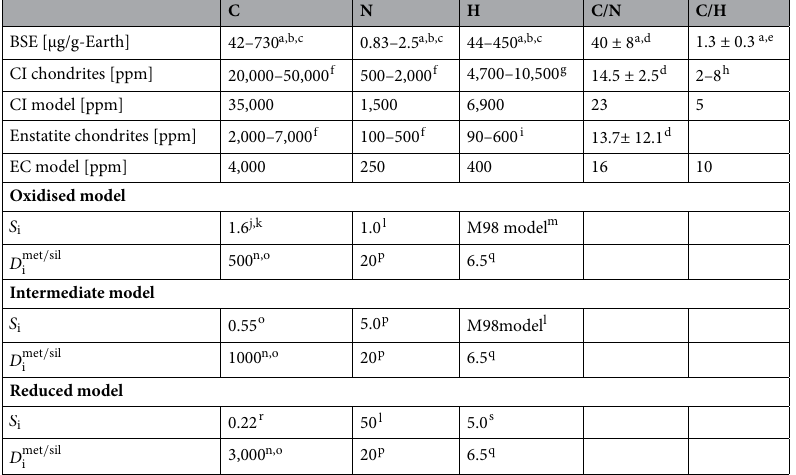
Table 1. List of key parameters for the model calculations. Observational data and model reference values for the abundances of C, N, and H in the bulk silicate Earth (BSE) and chondrites (assumed as building blocks, CI chondrites and enstatite chondrites). We set CI chondritic model, solubilities S i (the units are ( P i / 1MPa ) 1 / 2 ppm for reduced S H and ( P i / 1MPa ) ppm for the others, where P i is the partial pressure of each molecule i ), and the partitioning coefficients D i under each redox state by following Hirschmann 5 .